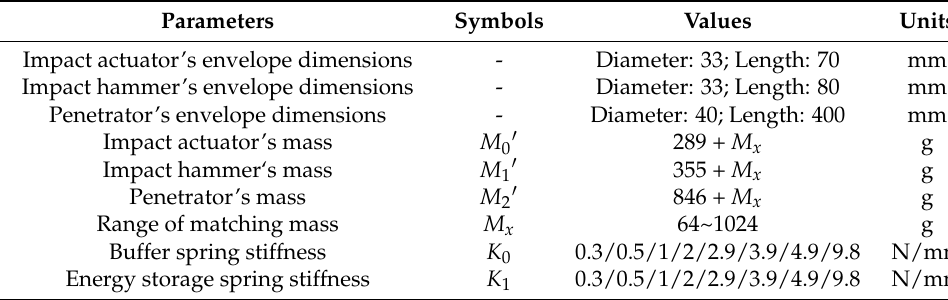
Table 7. The parameters used in the matching